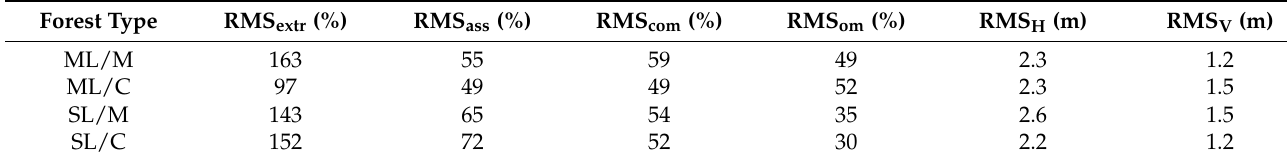
Table 3. Detection performance for each forest type.